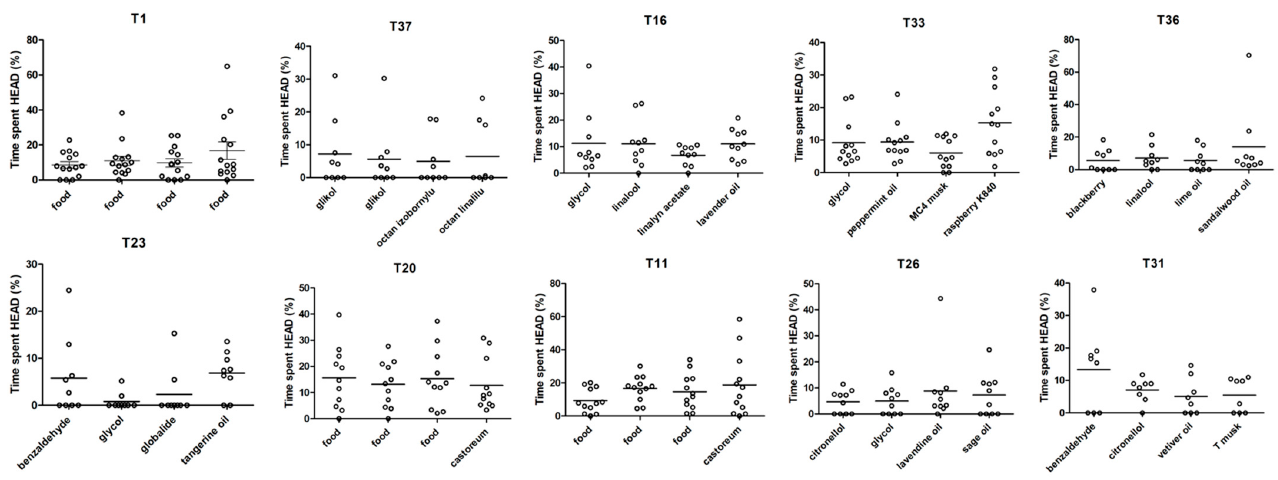
Figure 3. Percentage of time spent by the dog with its head within the samples presented in selected trials. Each dot represents an individual dog. No significant differences were observed in the time spent by the dog among the four smells presented in the single